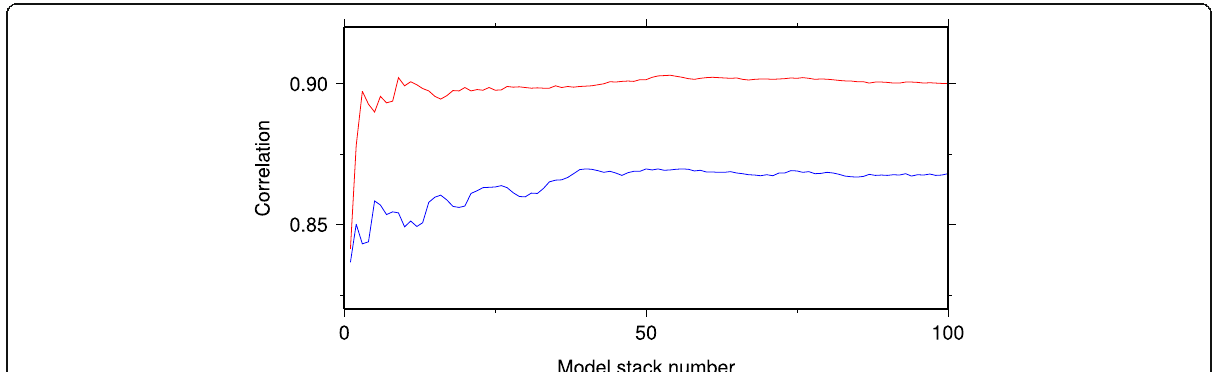
Fig. 3 Convergence of correlations between SDR and increasing number of stacks of the individual slip distributions. The red and blue lines represent the correlations of slip distributions generated using parameters R max = 0.2 and n a = 60 and parameters R max = 0.25 and n a = 20, respectively